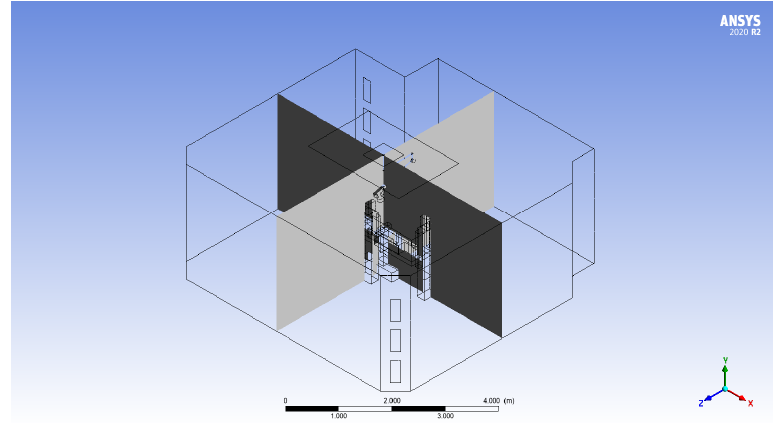
Figure 6. XY and YZ planes for displaying simulation outputs.